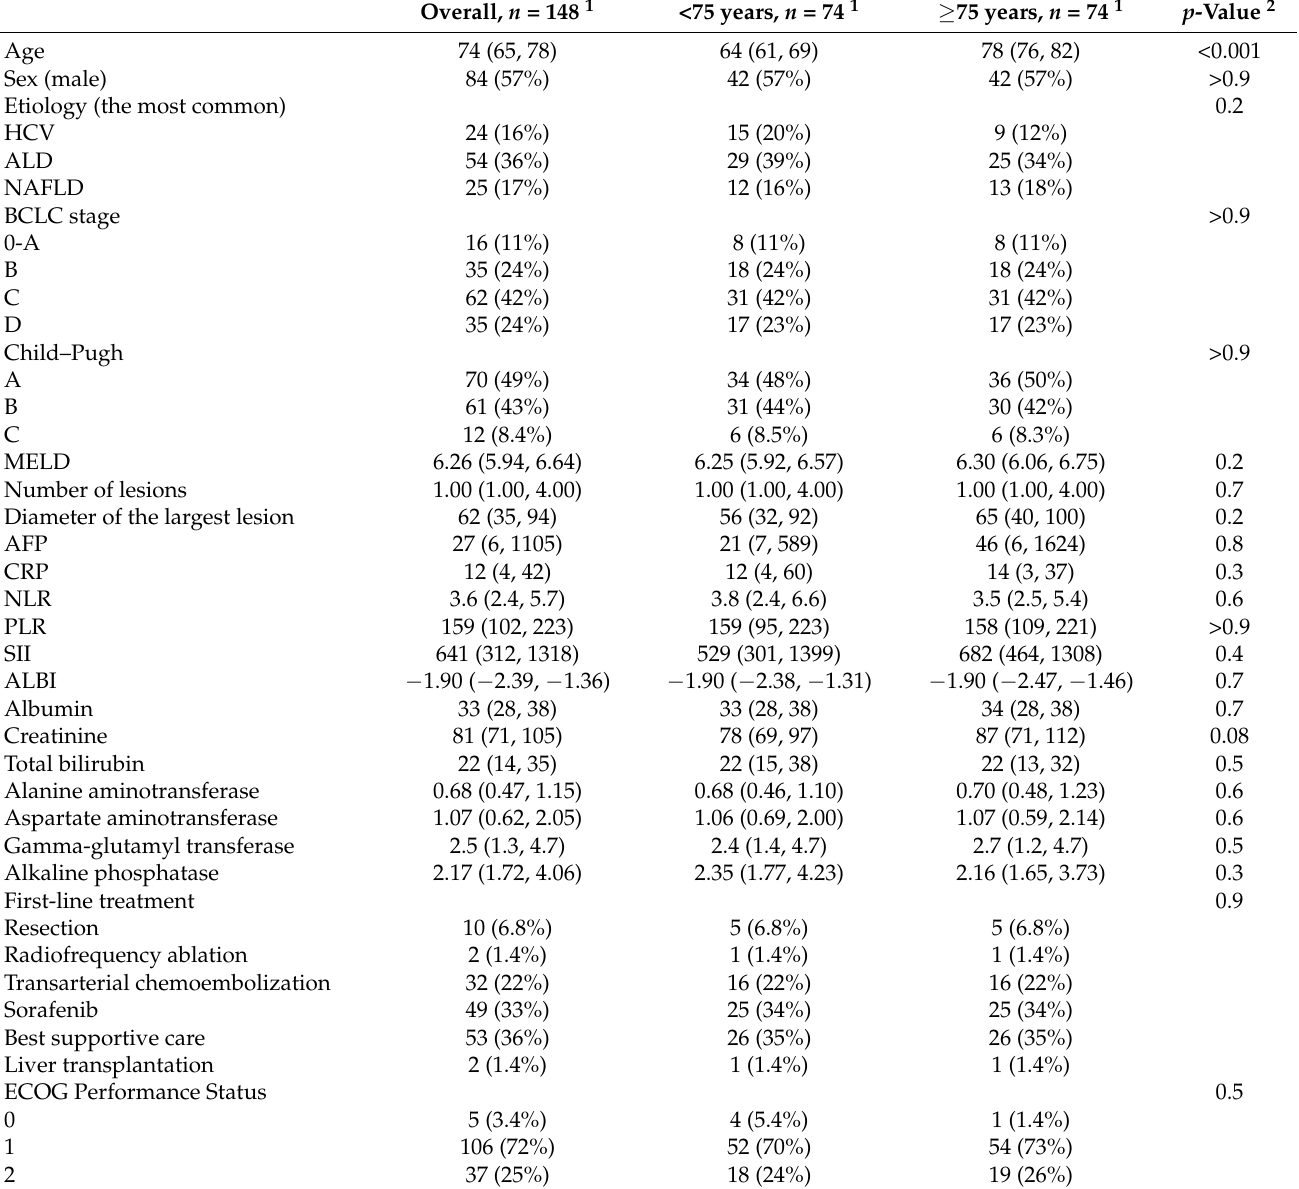
Table 1. Clinical and demographic characteristics of the HCC